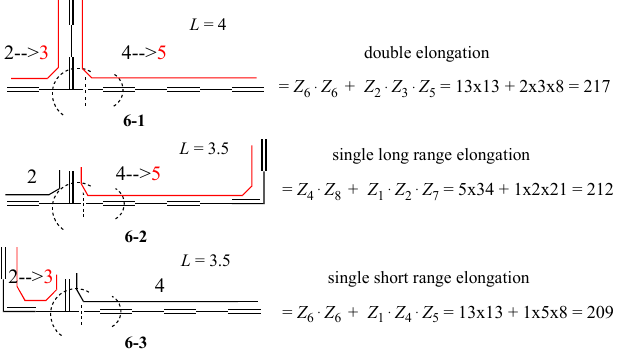
Figure 10. Back-of-envelope calculation of Z -indices of 6-1 ~ 6-3 , where Z n means the Z of path graph S n , or n -th Fibonacci number (See Appendix A). First cut the graph at the dashed straight line, then cut at the dashed round curve to apply the recursion formula. Bent lines are the same as in Figure 9.